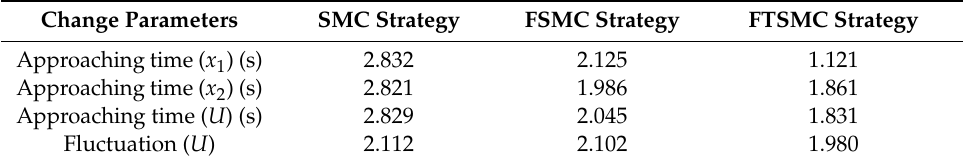
Table 4. Comparison of the sliding parameters of the FTSMC and SMC strategies.